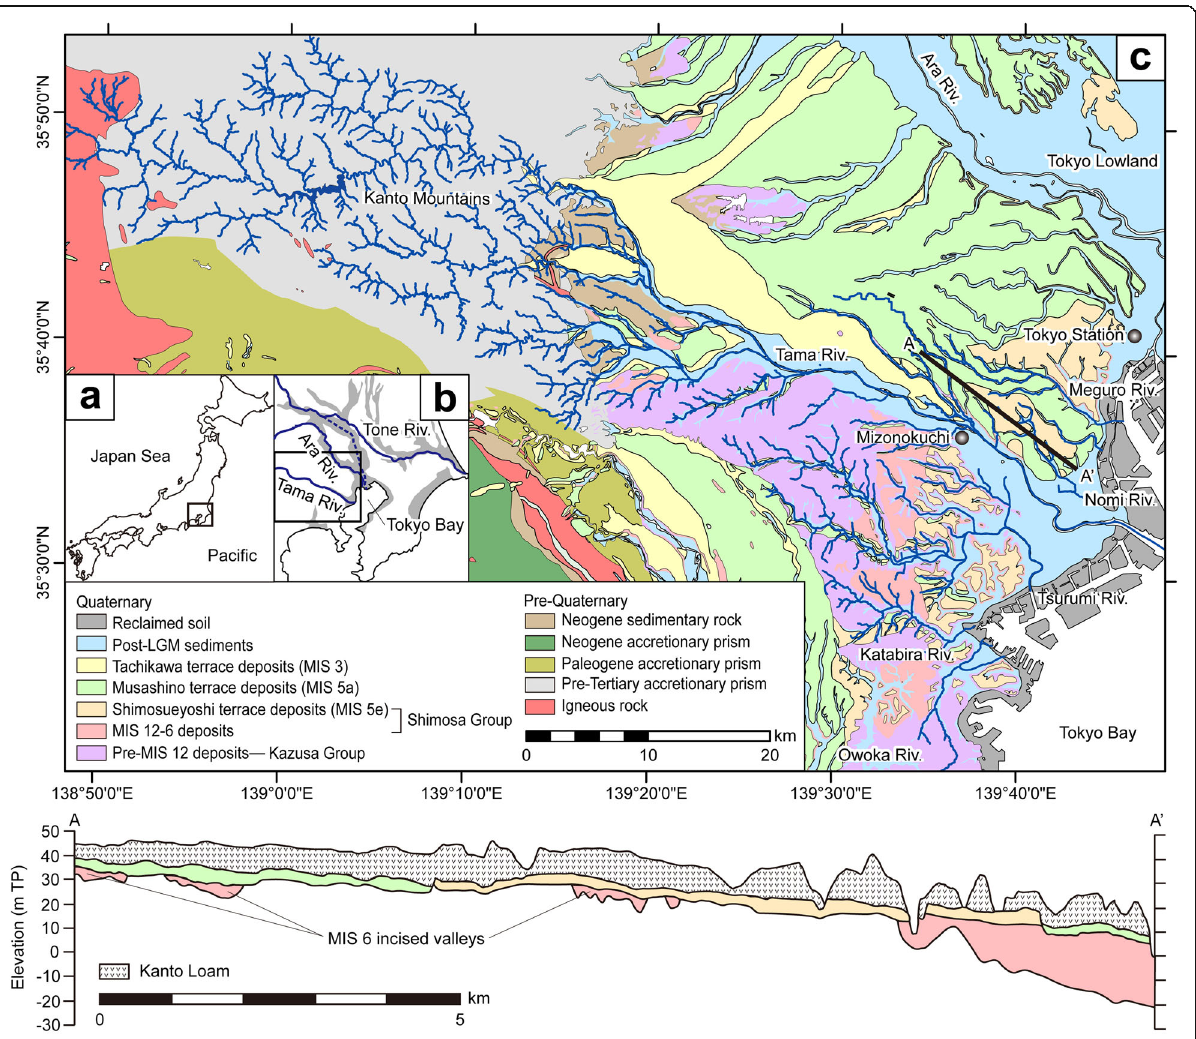
Fig. 1 Geological map of the Tama River system. a Japanese Islands. b Tokyo Bay. The gray shading indicates the distribution of lowland. The blue dashed line marks the course of the Tone River, which flowed into Tokyo Bay before being diverted to the Pacific during the 17th century. c Geological map and AA ’ cross section of the Tama River system based on Geological Survey of Japan, AIST